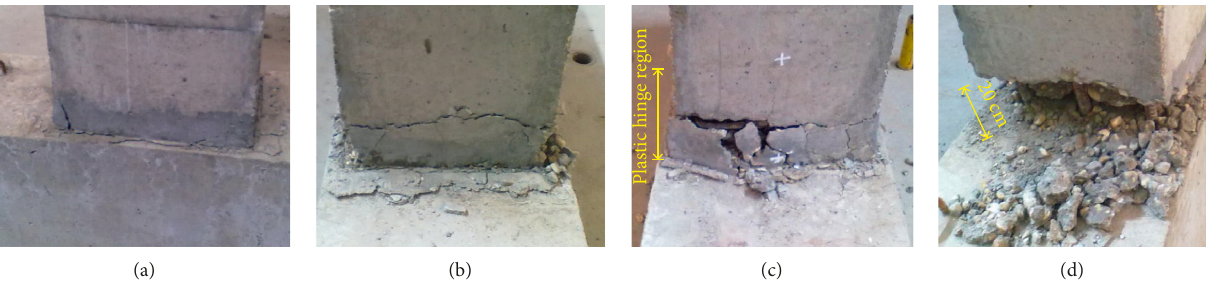
Figure 6: Damage of J-3 at (a) 10th loading cycle; (b) 30th loading cycle; (c) 70th loading cycle; (d) 100th loading cycle.